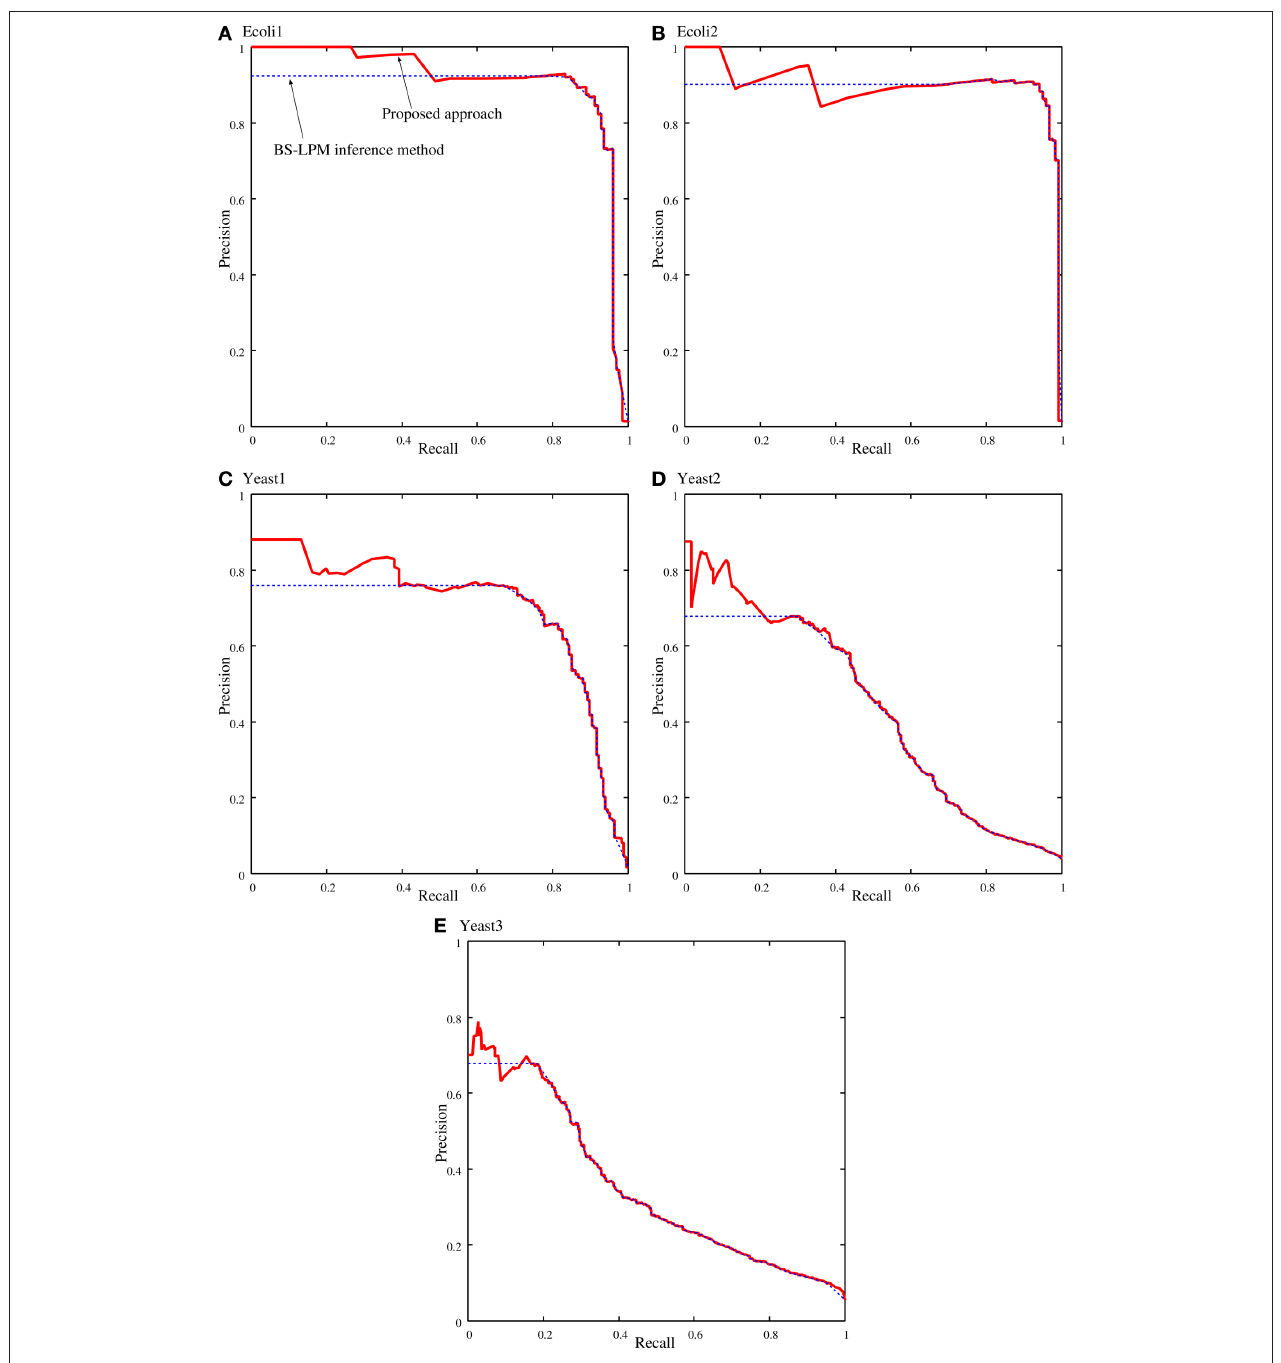
FIGURE 4 | Samples of the recall-precision curves of the proposed approach and the BS-LPM inference method on the problems of (A) Ecoli1, (B) Ecoli2, (C) Yeast1, (D) Yeast2, and (E) Yeast3. Solid and dotted lines represent the performance of the proposed approach and the BS-LPM inference method,